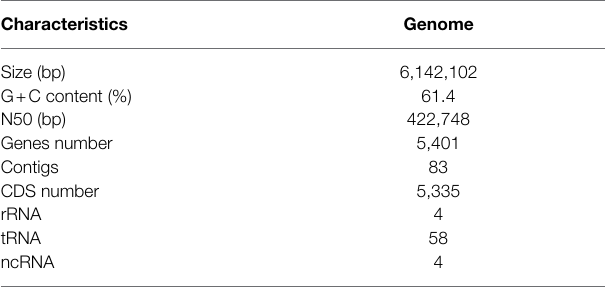
TABLE 1 | Draft genome features of P. mediterranea EDOX.